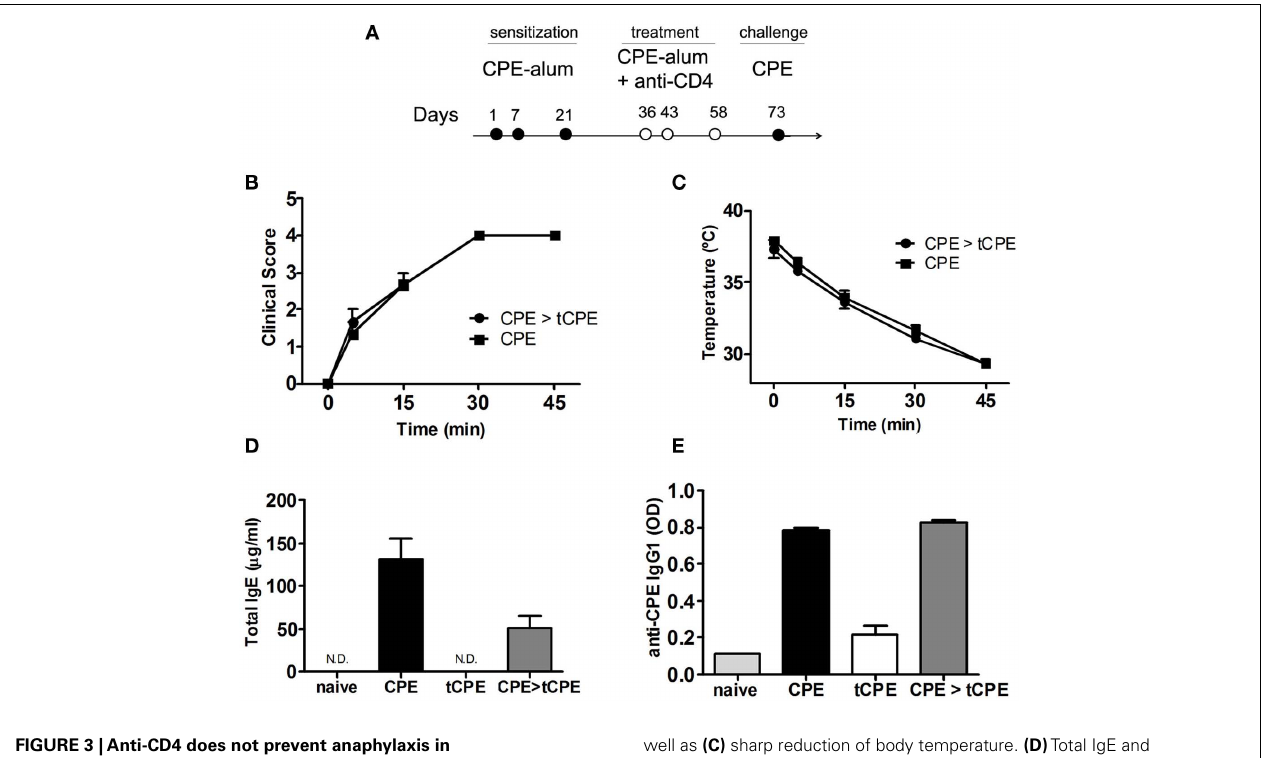
FIGURE 3 |Anti-CD4 does not prevent anaphylaxis in pre-sensitized mice with high titers of IgE. (A) C3H/HeJ mice were sensitized with CPE-alum on days 1, 7, and 21, and treated with anti-CD4 administered together with CPE at the indicated days. All mice were assessed at day 73 after challenge with 10mg CPE i.p. (B) Sensitized mice subsequently treated with anti-CD4 (CPE > tCPE) displayed anaphylactic manifestations identical to the control group, as